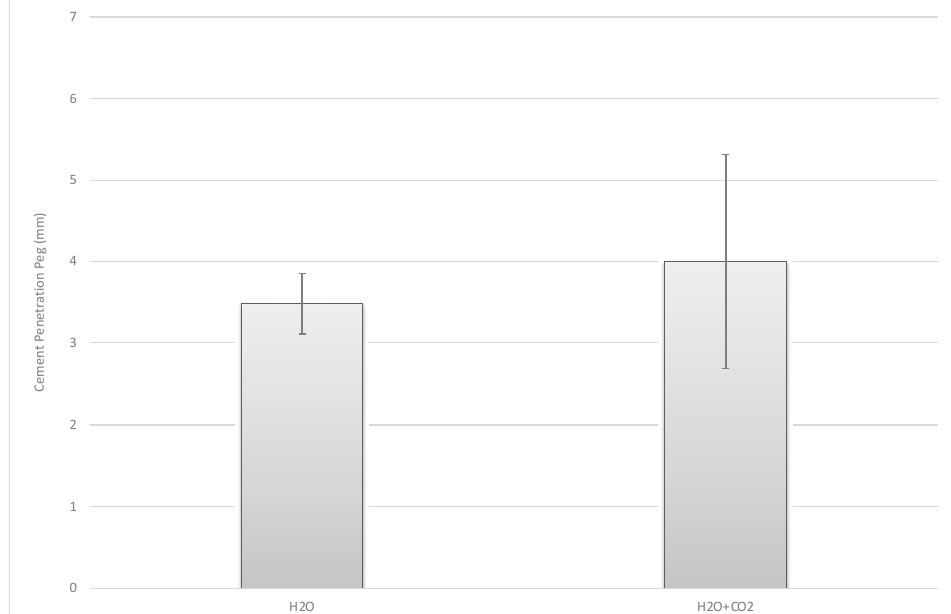
Figure 11. Mean cement penetration measurement points beneath the peg.